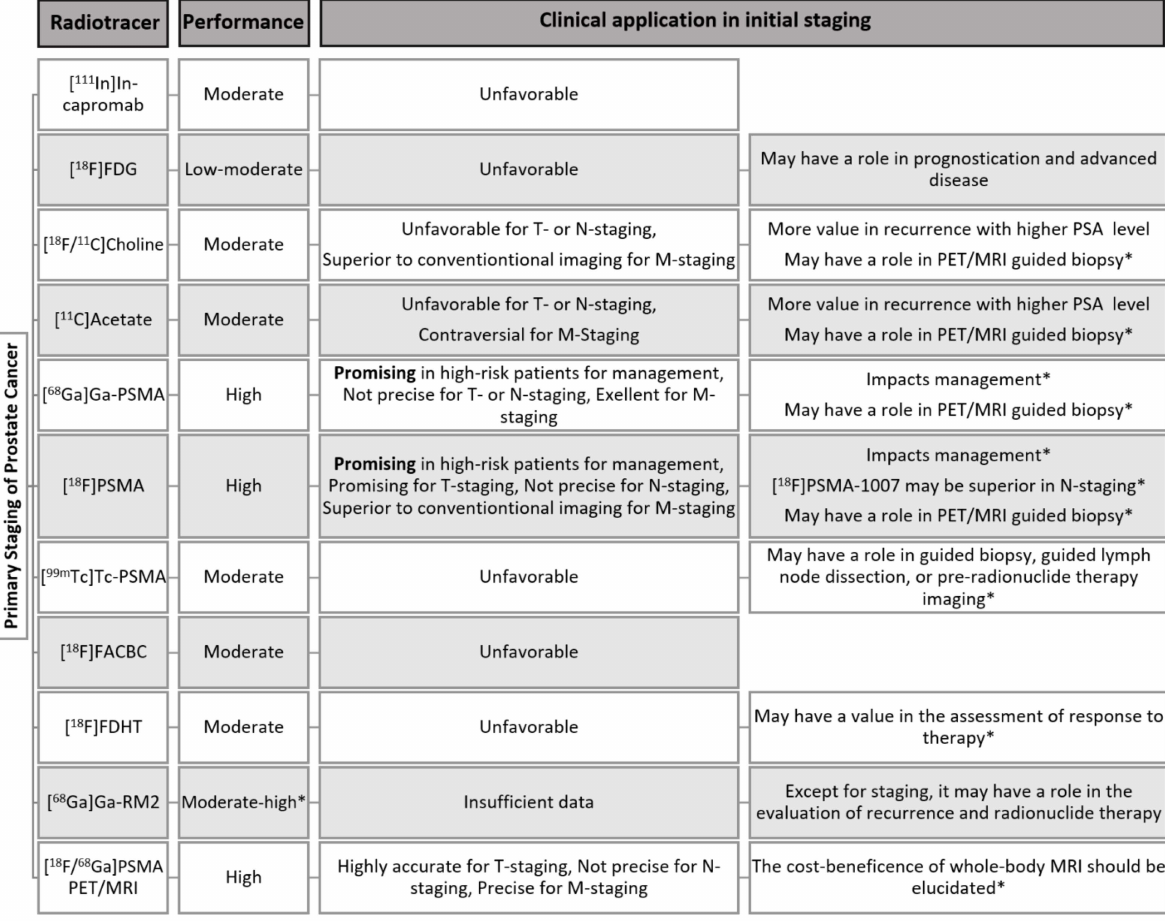
Figure 2. A summary of the role of nuclear medicine in the initial staging of prostate cancer. * The statements are based on limited but promising initial data, warranting further